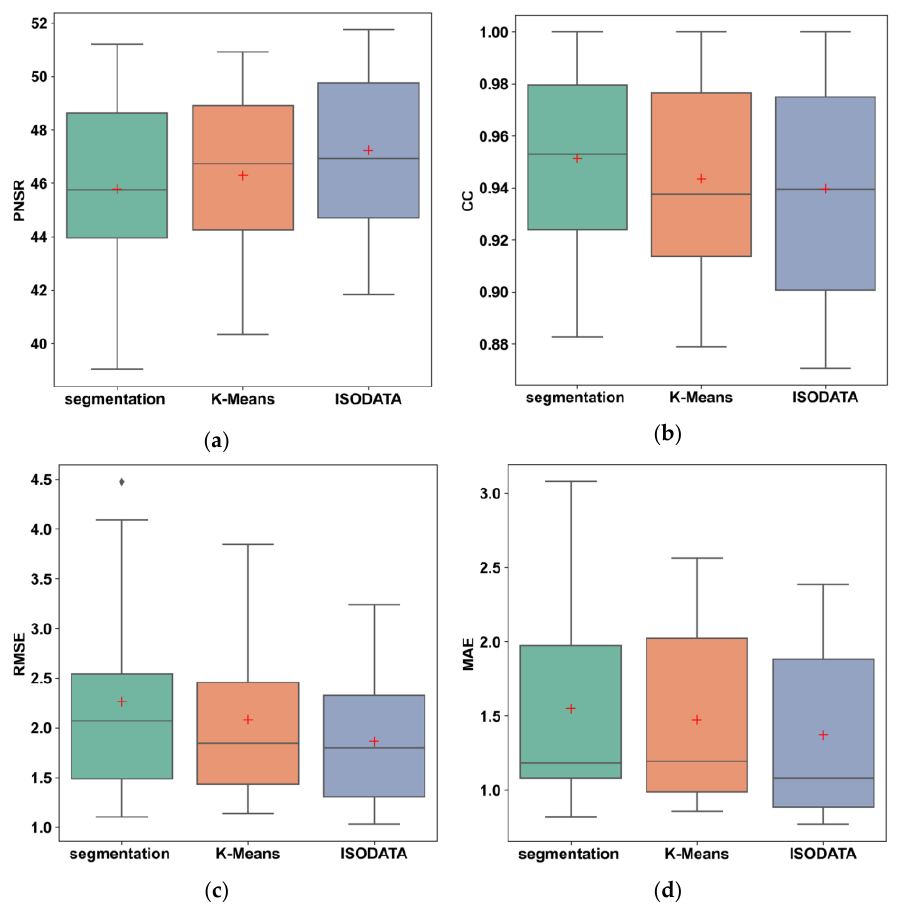
Figure 3. Comparison of model fusion results based on multiresolution segmentation algorithm, k-means algorithm, and ISODATA algorithm. ( a ) PNSR; ( b ) CC; ( c ) RMSE; ( d ) MAE.